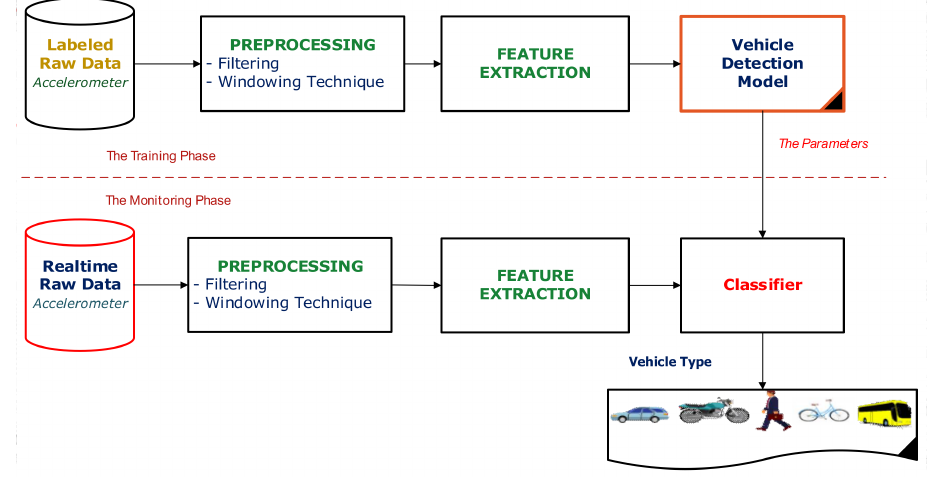
Figure 2. The framework of the Vehicle Detection Module